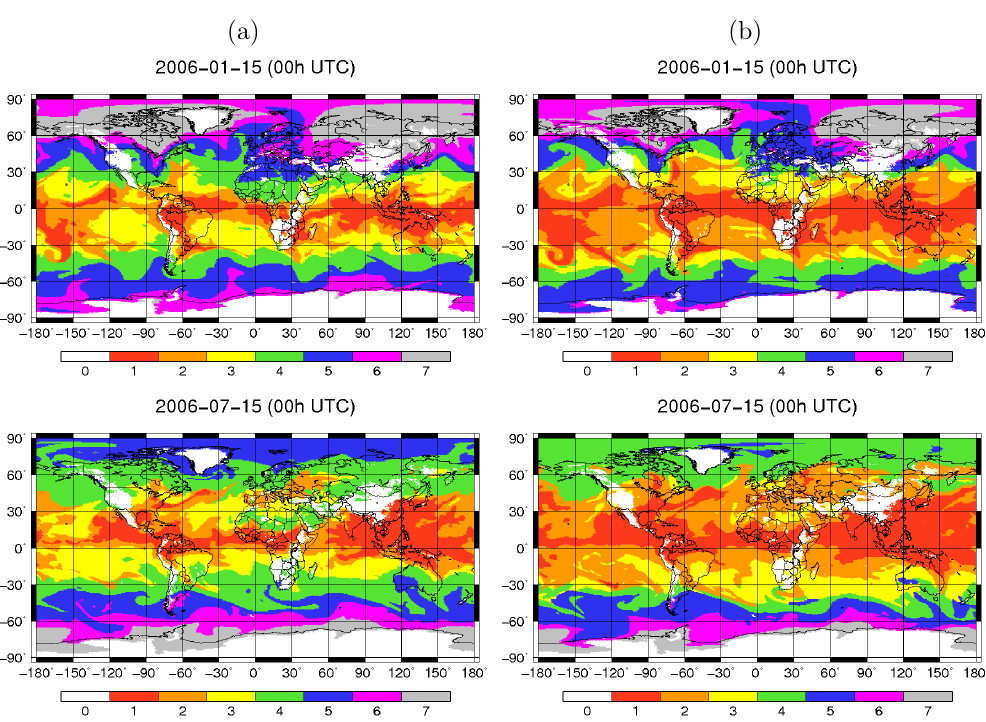
Figure 6. Seven-cluster unsupervised classification with the EM-VII model (a) and EM-EII ( ≈ k -means) (b) , for 2